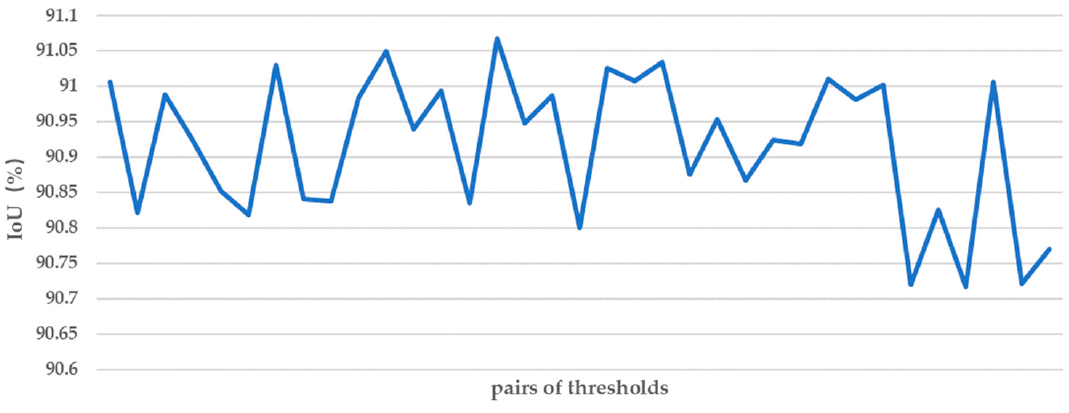
Figure 8. The IoU obtained with different pairs of thresholds for AEUNet++ in the WHU data set.